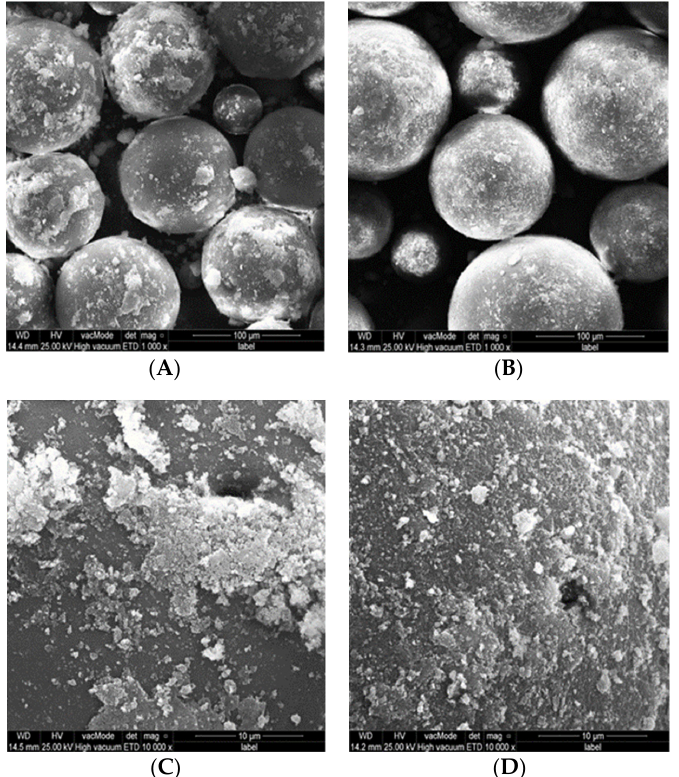
Figure 5. SEM for disc of control group, ( A ) PMMA alone; ( B ) PMMA with ethanol. SEM of 5% PMMA-MgO nanocomposite (Figure 6) and 5% PMMA-Ag nanocomposite (Figure 7) powder showed that non-ethanol-assisted mixing resulted in no attachment of NPs to the surface of PMMA particles and a lot of NPs agglomeration; this is easily noticed by observing NPs agglomeration between PMMA particles, whereas in ethanol-assisted mixing, NPs with PMMA showed better attachment of NPs to the surface of PMMA powder particles and good dispersion of NPs over the surface of PMMA particles, based on an absence of freely flowing NPs aggregation between PMMA particles in comparison to the non- ethanol-assisted mixing.